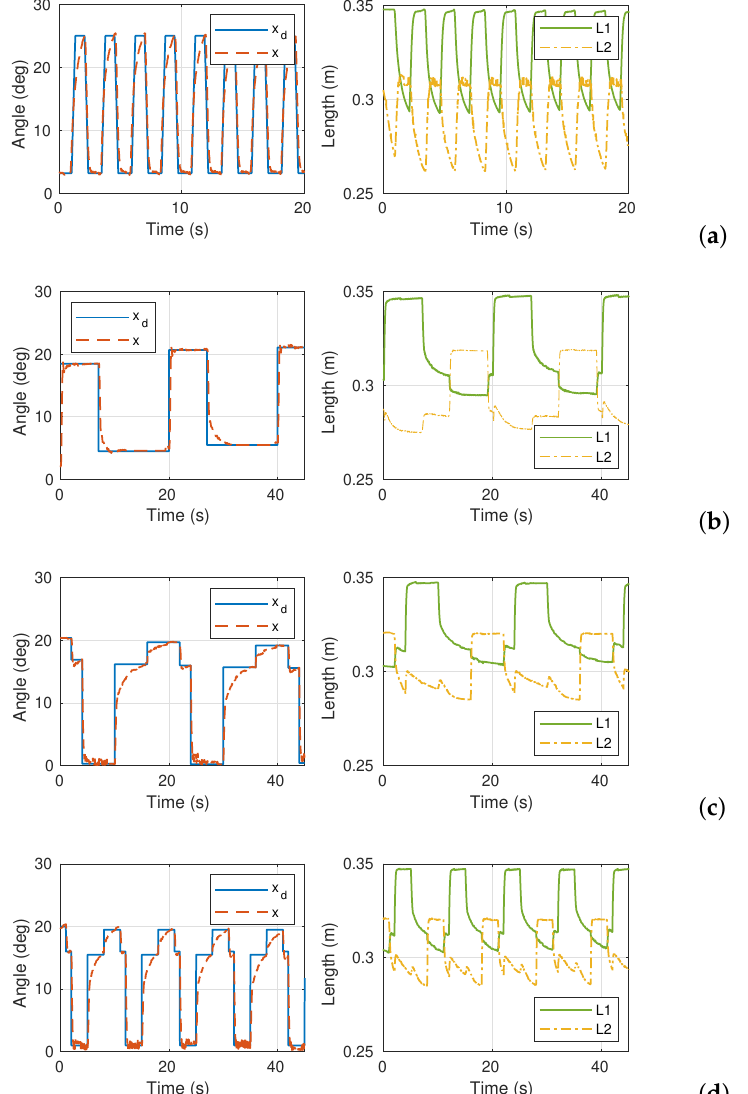
Figure 17. Experimental results on trajectory tracking with manipulator. ( a ) The performance tracking a high frequency trapezoidal trajectory; ( b ) the performance tracking a stepped high amplitude square trajectory; ( c ) the performance tracking a low-frequency convex trajectory; ( d ) the performance tracking a high-frequency convex